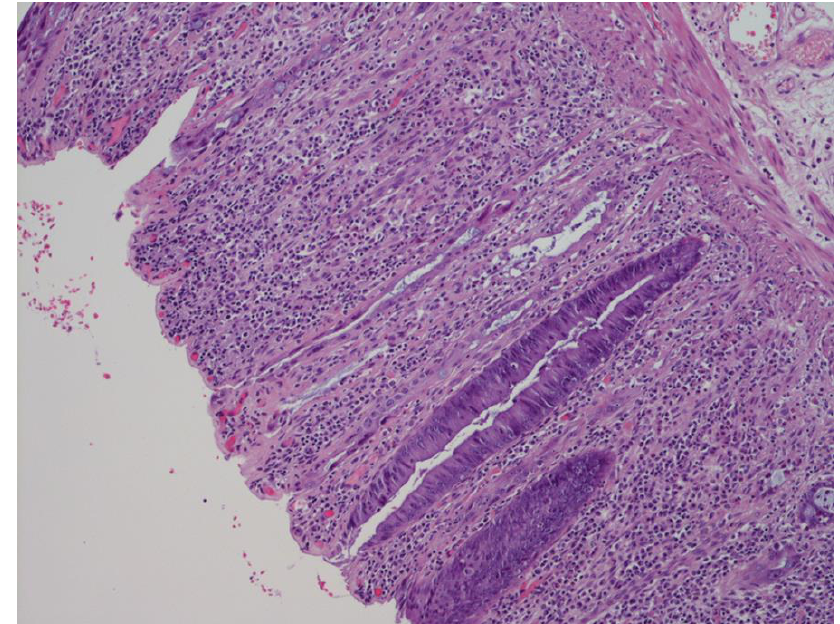
Figure 3. “Dysplastic-like” features in radiation-damaged non-neoplastic mucosa in PSRT sample: glands with slit-like lumen and flattened epithelium close to glands with pseudostratified epithelium (Hematoxylin and Eosin (HE) 200 times magnified).